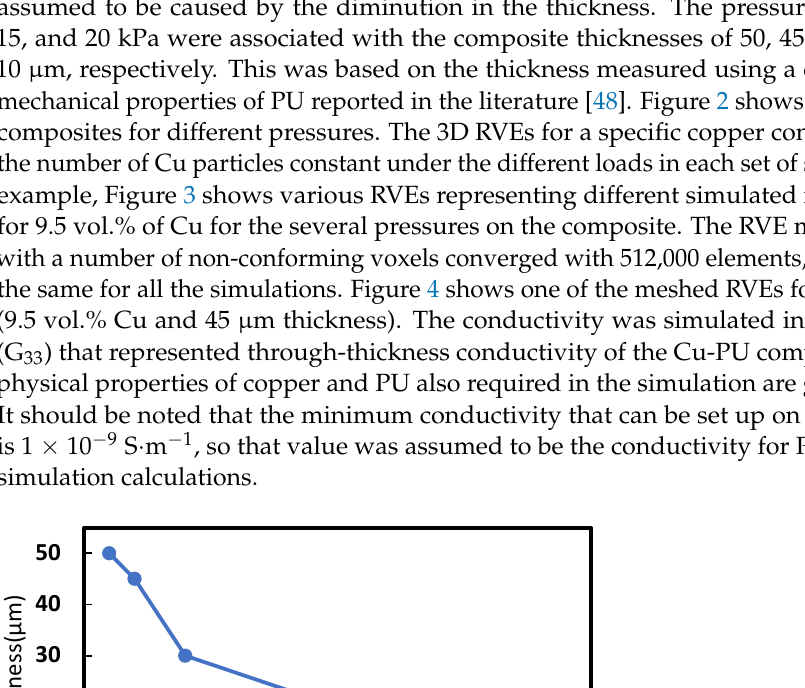
Table 2. Physical properties of the components of Cu-PU film composite [49] .